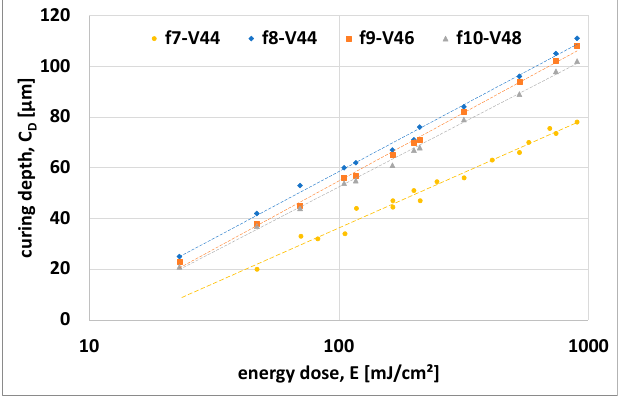
Figure 7. 𝐶 (cid:3005) after adjustment of initiator content from f7 to f8; f9 and f10, as f8. Figure 7. C D after adjustment of initiator content from f7 to f8; f9 and f10, as f8. Suspensions with a solid content of 46 and 48 vol% show a similar behavior, with a small decrease in cure depth at increasing solid contents. Based on this result, a suspension with a solid content of 46 vol%, a dispersant content such as f12, and an initiator content following the results of the fourth stage were chosen for all test samples.